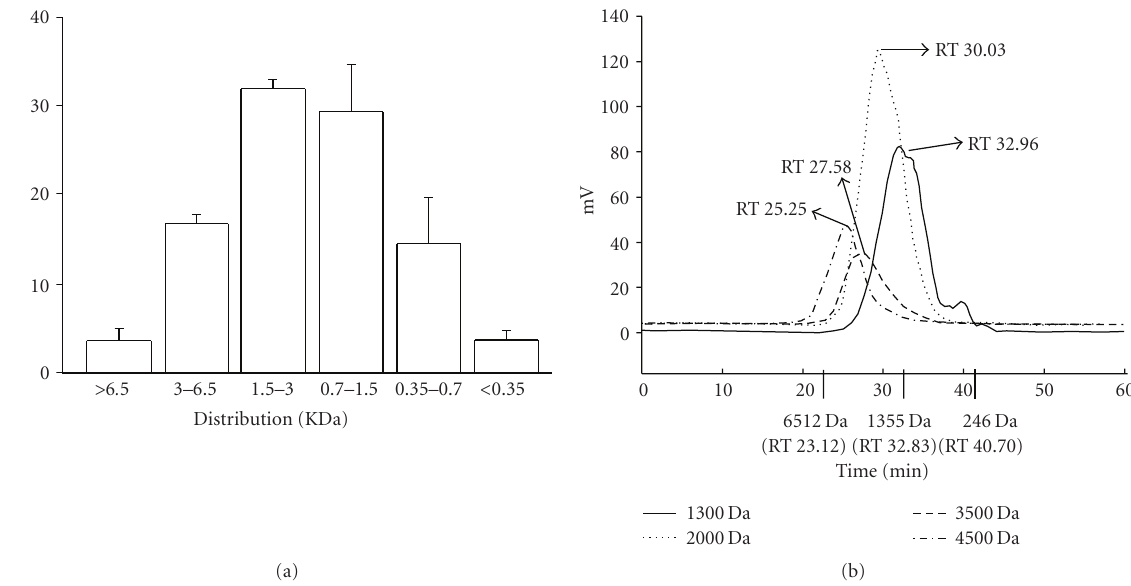
Figure 4: Size distribution of FSCPs. (a) Fish scale hydrolysates were separated by gel chromatography (superdex peptide 10/300 GL columns); molecular sizes were determined for each fraction; size distributions were plotted accordingly. The size distribution (KDa) is expressed as means ± SEM. (b) Size profiles of FSCPs. Protein standards (Bio-Rad, California, USA) are cytochrome C (Mr = 12500 Da), aprotinin (Mr = 6512 Da), vitamin B12 (Mr = 1355 Da), and cytidine (Mr = 246 Da). The average molecular weights (MWs) were determined to be 4500, 3500, 2000, and 1300 Da for the four indicated groups.